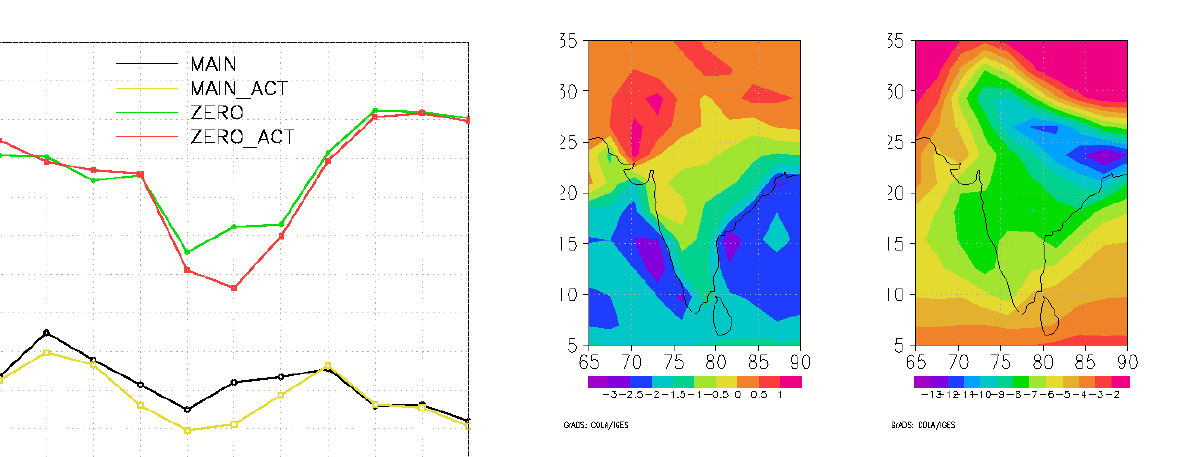
Figure 5. Seven-year average anthropogenic radiative forcing (in Wm − 2 ) in the area 65–90 ◦ E, 5–35 ◦ N in the MAIN simulation with GAINS emissions and without aerosol–cloud activation at the top of the atmosphere (left) and at the surface